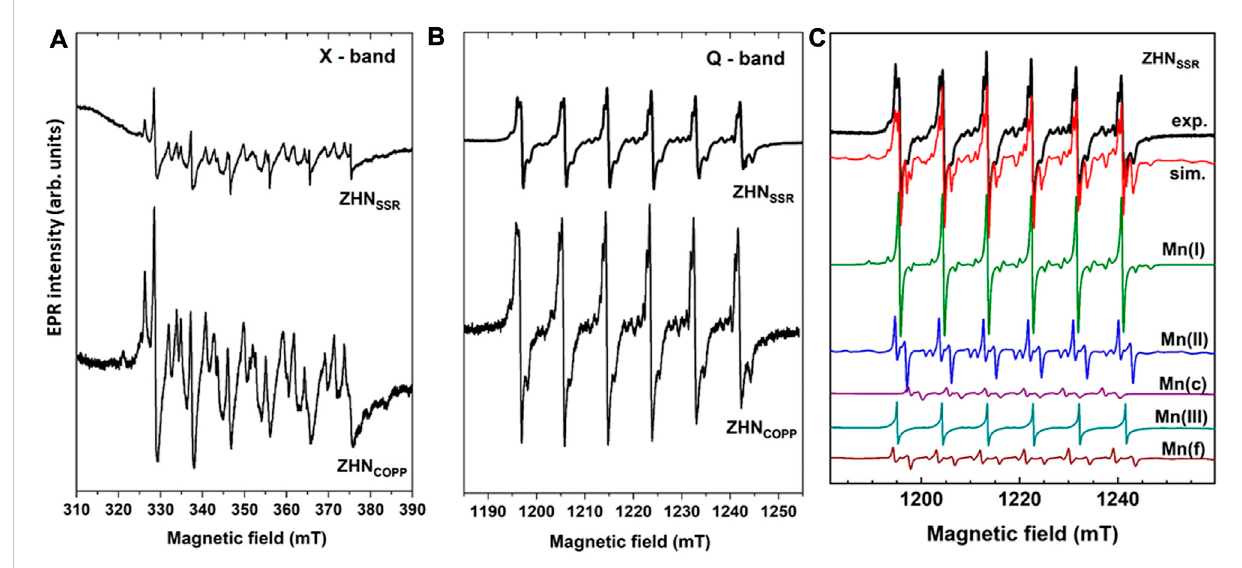
FIGURE 5 EPRspectraoftheas-preparedsamplesmeasuredatRTinX-band(9.86 GHz) (A) ,andQ-band(34.12 GHz) (B) . (C) Experimental(exp.)andsimulated (sim.) EPR spectrum in Q-band of the ZHN SSR sample. The component spectra of the indicated centers, calculated with the SH parameters from Table 2, are presented